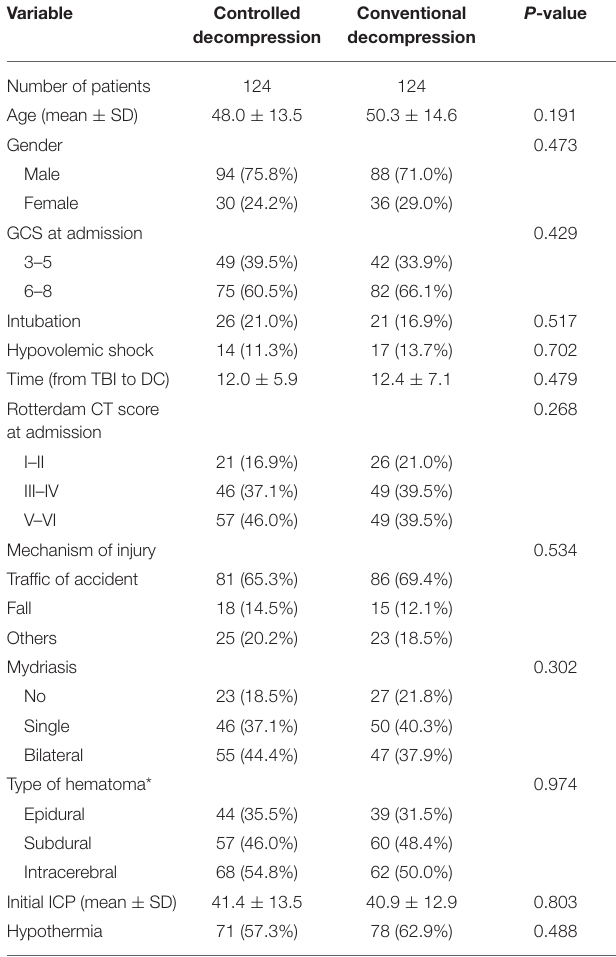
TABLE 1 | Demographic and baseline characteristics of the study population in two group.